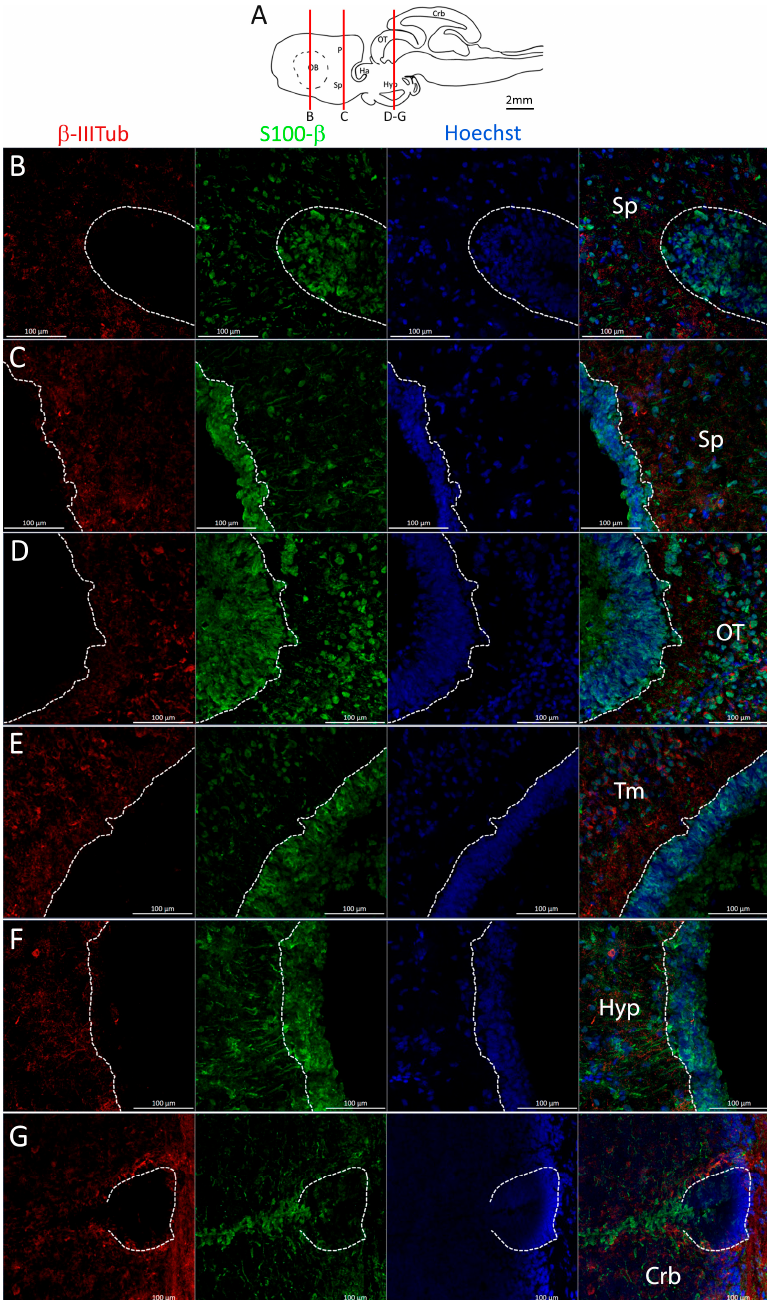
Figure 21. Identification of newly differentiated neurons in Scyliorhinus canicula brain. ( A ) Sagittal representation of S. canicula brain. The red lines indicate the rostro-caudal localization of the sections from which magnifications are taken. ( B ) Magnification of the neurogenic niche localized in the ventral area of the anterior telencephalon. ( C ) Magnification of the neurogenic niche localized in the ventral area of the posterior telencephalon. ( D ) Magnification of the neurogenic niche localized in the optic tectum. ( E ) Magnification of the neurogenic niche localized in the tegmentum. ( F ) Magnification of the neurogenic niche localized in the hypothalamus. ( G ) Magnification of the neurogenic niche localized in the dorsal anterior cerebellum. In all panels, white dashed lines indicate the border of the neurogenic niche. Abbreviations: Sp: subpallium, OT: optic tectum, Tm: tegmentum, Hyp: hypothalamus, Crb: cerebellum.